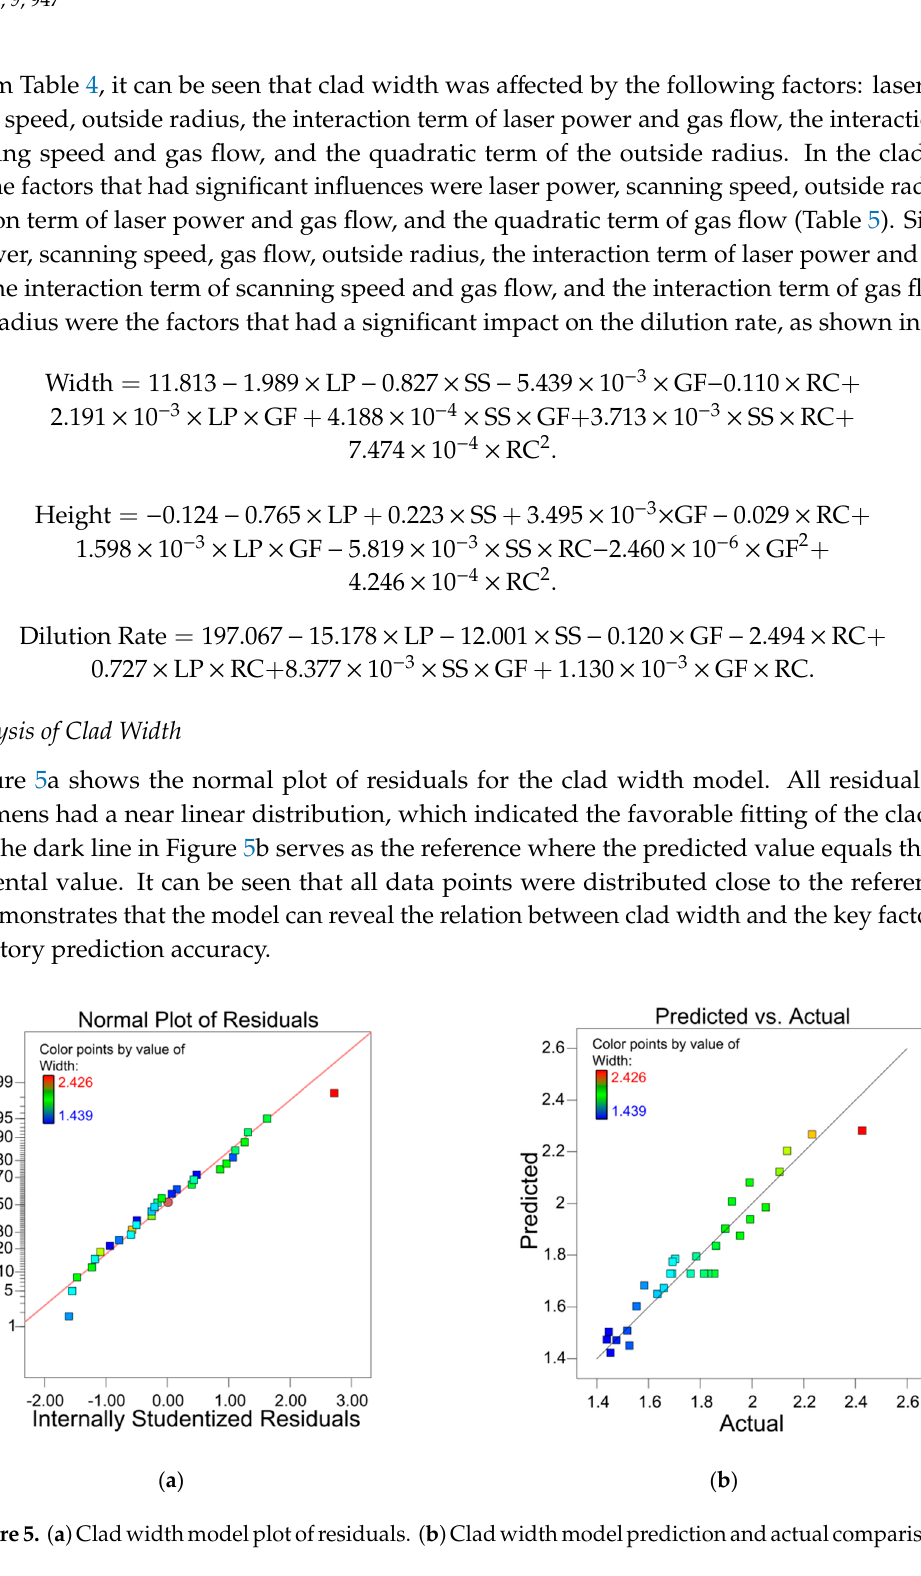
Table 6. Analysis of variance of dilution rate.